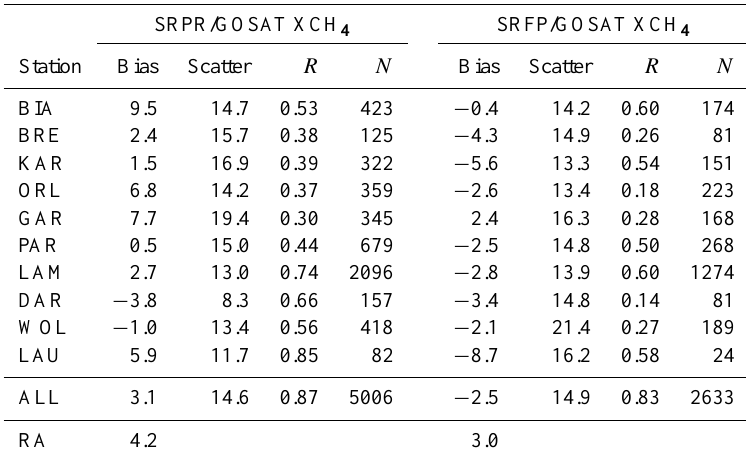
Table 10. SRPR and SRFP XCH 4 validation results for all individual stations and using all data combined (ALL). All results apart from R and N are in ppb units.